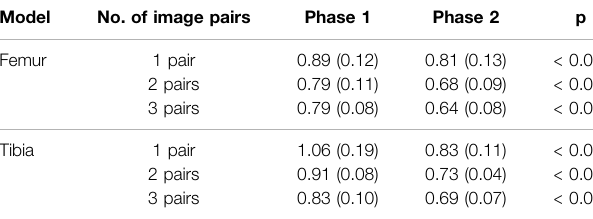
TABLE 2 | Means (standard deviations) of the RMSE (unit: mm) for the in vivo femurandtibiashapereconstructionafterPhase1andPhase2usingthetwo- phase optimization